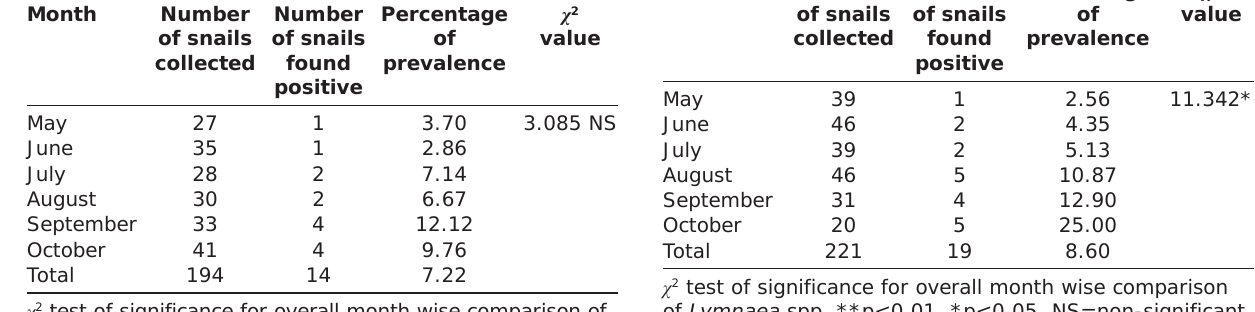
Table-4: Overall month wise prevalence of Lymnaea spp. having infective stages of parasites in and around Ranchi. Percentage Month Number Number χ 2 of of snails of snails prevalence collected found positive